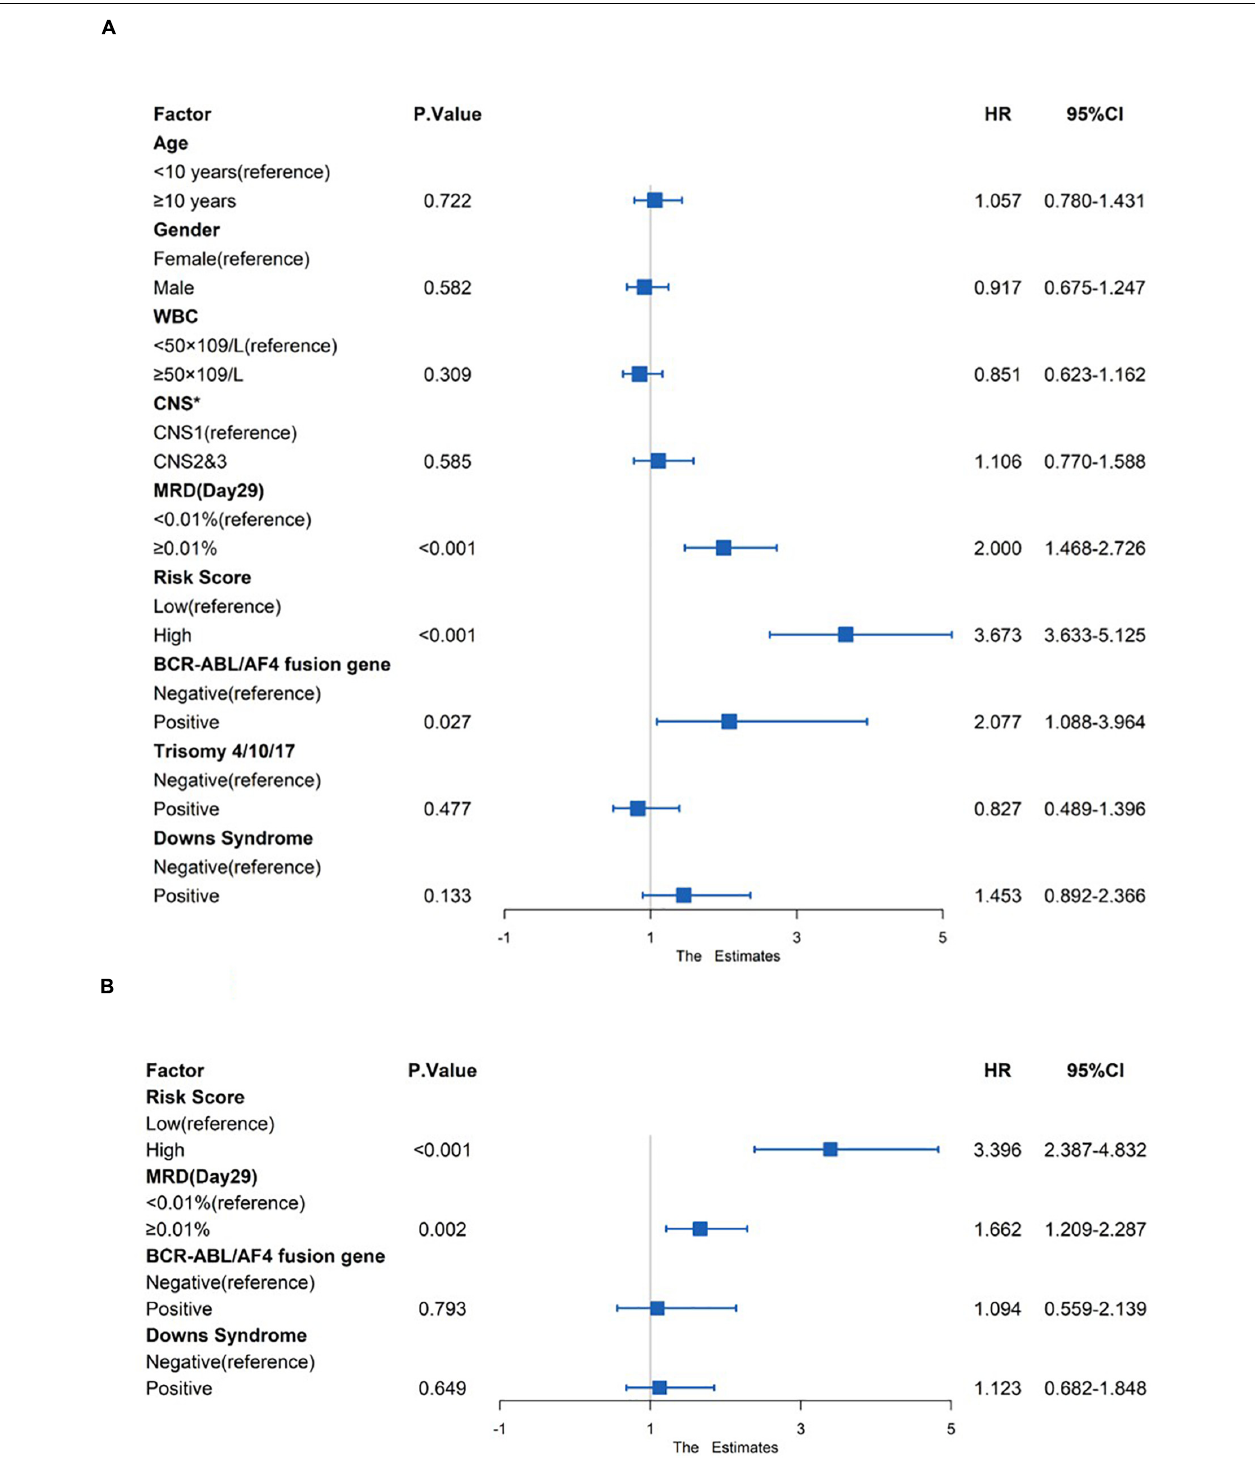
FIGURE 8 | Prognostic prediction value of four-gene prognostic risk models in Total Set. (A) Univariate Cox regression analysis of OS. (B) Multivariate Cox regression analysis of OS. ‘*’ means CNS, Central Nervous System, CNS1 = CNS negative, CNS2 ≤ 5 WBC/ µ L in CSF with blasts, CNS3 = CNS positive.